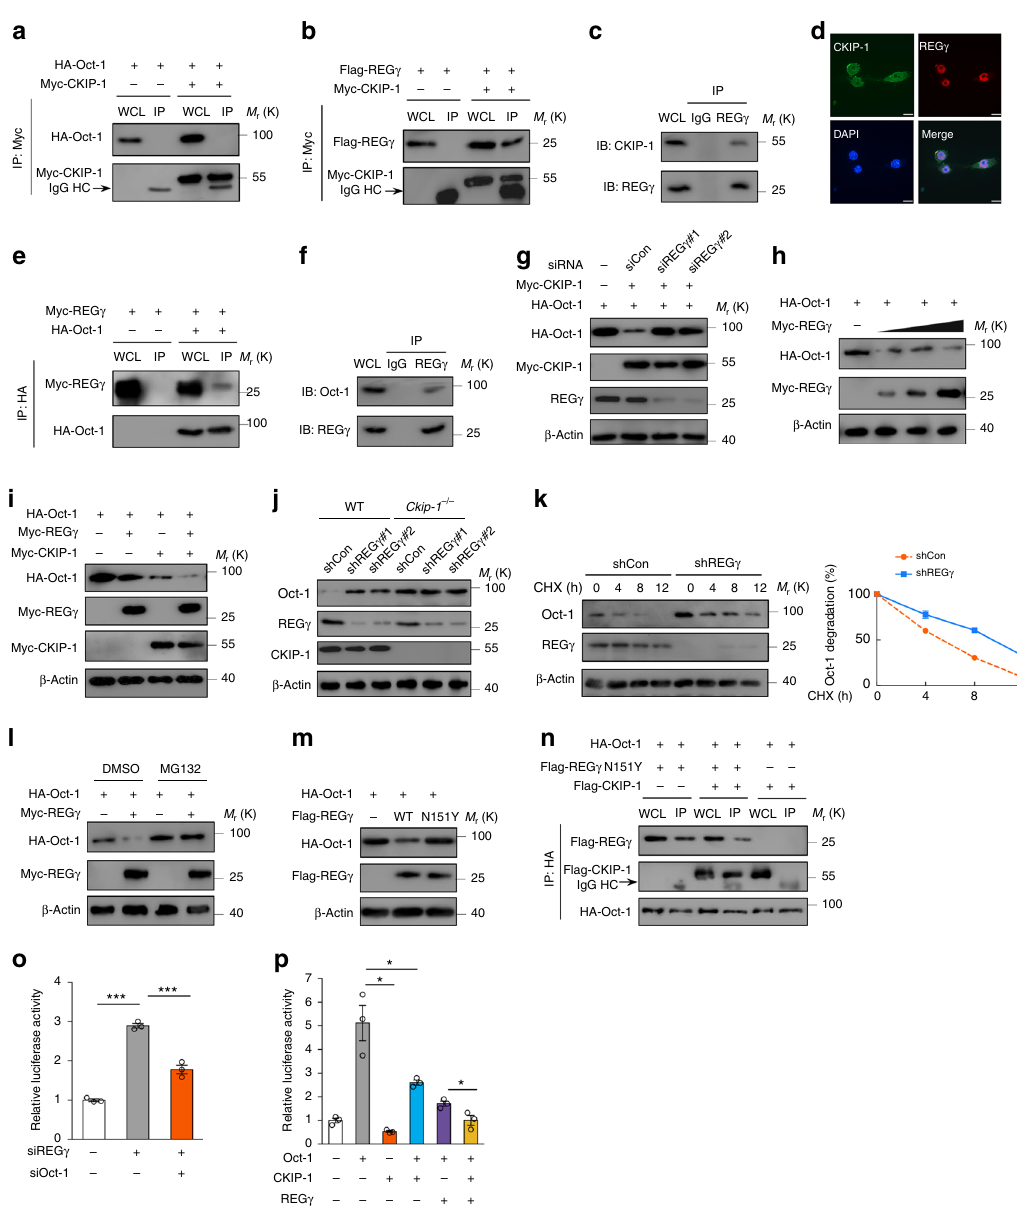
Fig. 3 CKIP-1 regulates the stability of Oct-1 via REG γ -dependent proteasome degradation. a Co-IP of Oct-1 and CKIP-1. HA-Oct-1 and Myc-CKIP-1 were transfected into HEK293T cells. IP immunoprecipitation, WCL whole cell lysate. b Co-IP of CKIP-1 and REG γ . Flag-REG γ and Myc-CKIP-1 were transfected into HEK293T cells. c Co-IP interaction assay for the endogenous interaction between CKIP-1 and REG γ in BMDMs. d Immuno fl uorescence assays show the co-localization of CKIP-1 and REG γ in BMDMs. Scale bar, 25 μ m. e Co-IP of Oct-1 and REG γ . Myc-REG γ and HA-Oct-1 were transfected into HEK293T cells. f Co-IP interaction assay for the endogenous interaction between REG γ and Oct-1 in BMDMs. g HA-Oct-1, Myc-CKIP-1, and REG γ siRNA were cotransfected into HeLa cells and proteins were analyzed by western blot. h HEK293T cells were co-transfected with HA-Oct-1 with increasing amount of Myc-REG γ as indicated. i HEK293T cells were transfected with HA-Oct-1, Myc-REG γ , Myc-CKIP-1 or together as indicated. j Knockdown of REG γ levels in WT and Ckip-1 − / − macrophages transfected with REG γ -shRNA #1, #2 by lentivirus. k Knockdown of REG γ in WT macrophages followed by CHX (10 μ g per ml) treatment for the indicated times. l The transfected HEK293T cells were treated with MG132 (20 μ M) as indicated for 8 h before harvest, and cell lysates were subjected to western blot. m HEK293T cells were transfected with HA-Oct-1 and WT REG γ or N151Y mutant, and cell lysates were subjected to western blot. n HEK293T cells were transfected with HA-Oct-1, Flag-CKIP-1, and Flag-REG γ N151Y mutant as indicated, and Co-IP assays were performed. o HeLa cells were transfected with siRNA against REG γ or Oct-1 as indicated and then cells were transfected with Renilla luciferase plasmids together with LOX-1/pGL3 luciferase plasmid. p Luciferase assay in HEK293T cells were transfected with the LOX-1/pGL3 luciferase plasmid and CKIP-1, Oct-1, REG γ plasmids as indicated. Data represent mean ± s.e.m. of n = 3 biologically independent experiments ( k , o , p ). P values were calculated by two-way ANOVA ( k ) and two-tailed Student ’ s t -test ( o , p ). * P < 0.05, ** P < 0.01, *** P < 0.001. The precise P value and statistics source data are shown in Supplementary Data 2. Unprocessed original scans of blots are shown in Supplementary Fig.